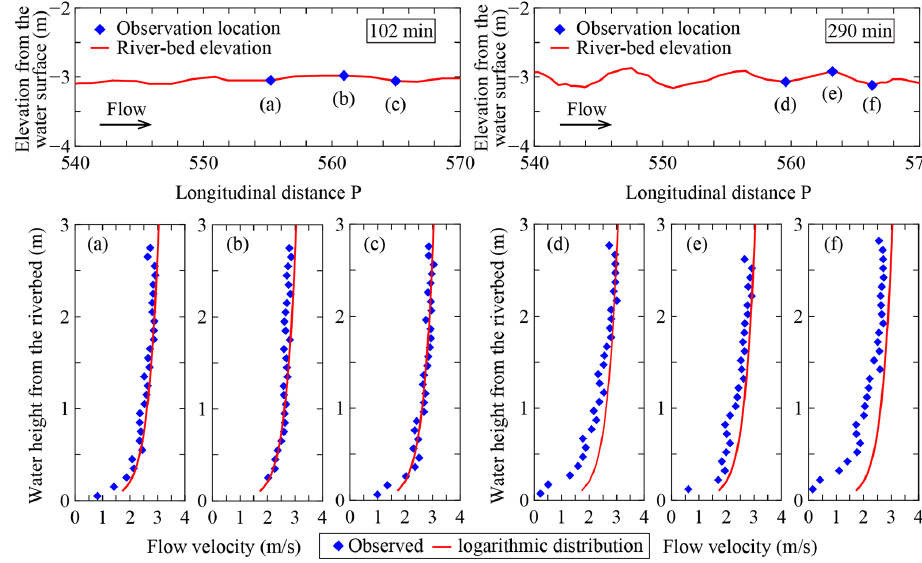
Fig. 7. Vertical velocity observed on the sand waves and logarithmic distribution (Case